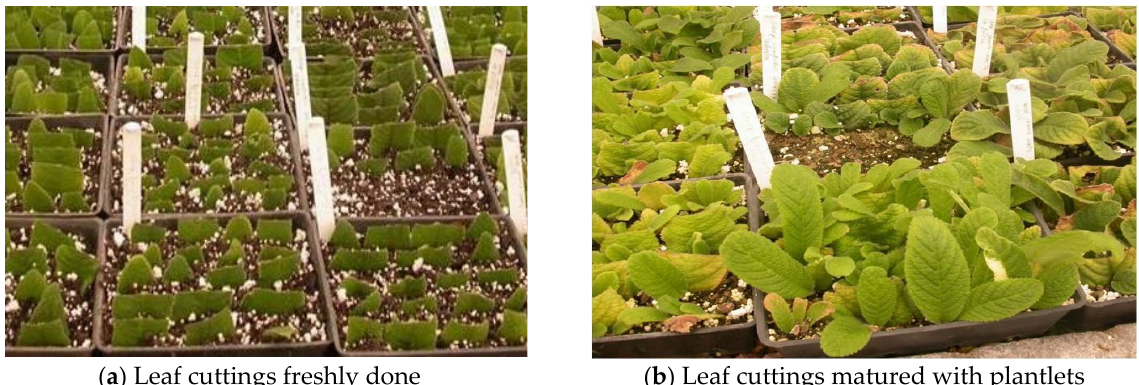
Figure 1. Leaf cuttings of S. formosus provided n = 50 plants cultivated from one initial mother plant obtained from Kirstenbosch National Botanical Garden, Cape Town (Photos: C. Viljoen).